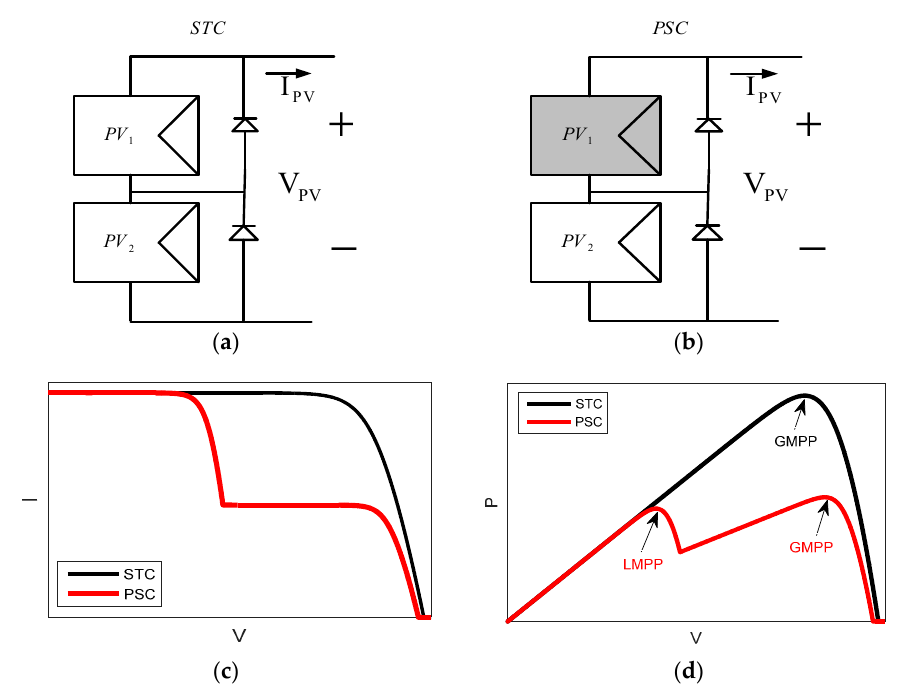
Figure 2. PV panel ( a ) STC configuration, ( b ) PSC configuration, ( c ) I-V curve, ( d ) P-V curve.